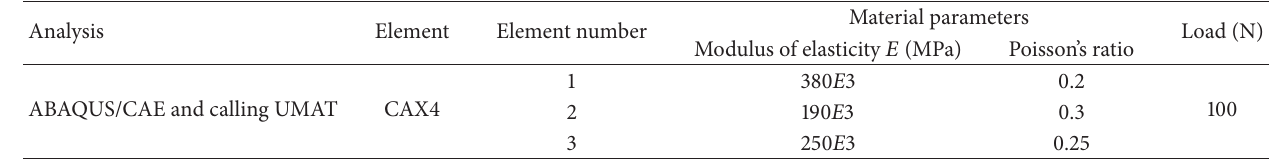
Table 3: The material property definition for elements.